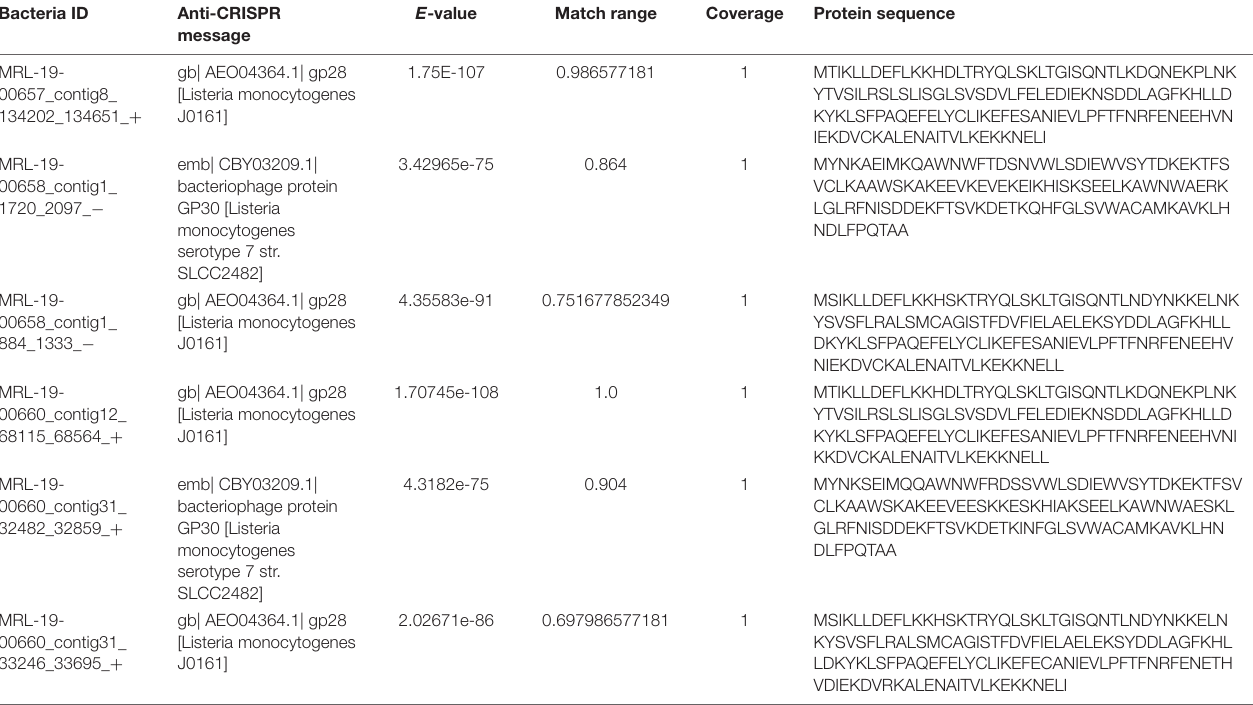
TABLE 6 | Anti-CRISPR